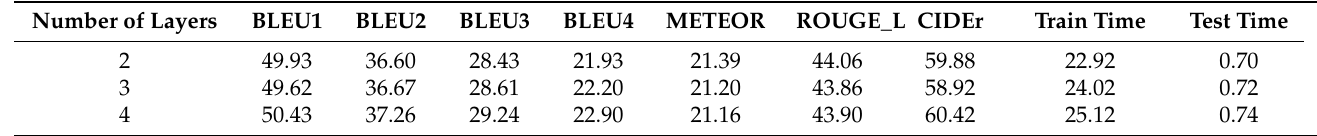
Table 4. Results of changing the number of decoder layers.